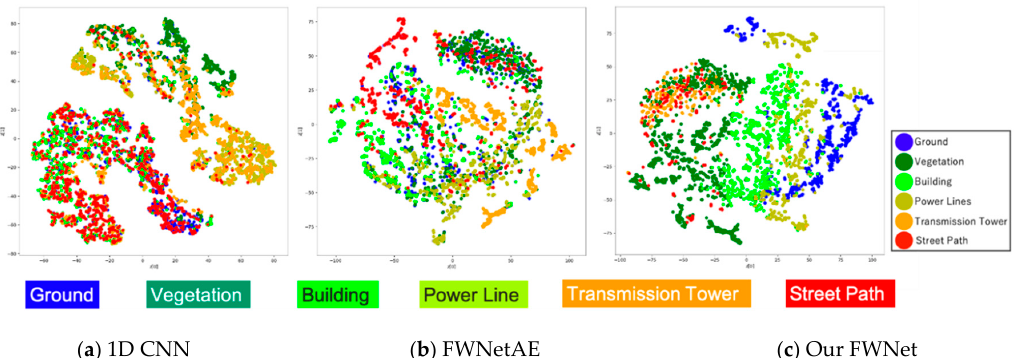
Figure 10. Latent space visualization and t-distributed stochastic neighbor embedding (t-SNE) projection of the feature vectors from the input data projected on a 2-dimensional space. We used the same 100 randomly selected data in each class from the test data for the three models.